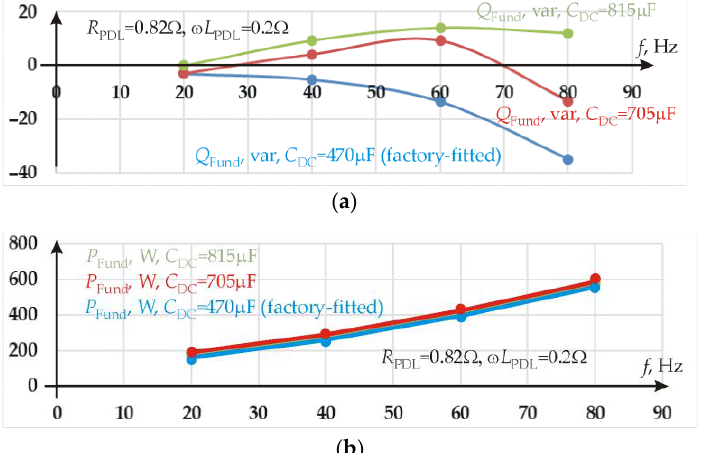
Figure 19. The power at the point of SIMOVERT P 6SE21 VFD and five different type of LED lighting devices connection to PDL at a function of induction motor frequency in case of different DC circuit capacitance value: ( a ) reactive power; ( b ) active power.